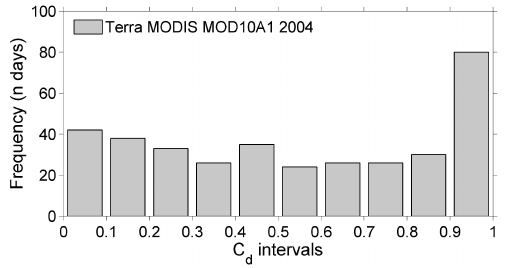
Figure 5. Absolute frequency of the daily cloud percentage C d from Terra MOD10A1: year 2004.